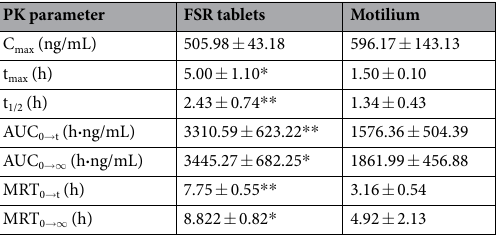
Table 1. Pharmacokinetic parameters of Motilium and DOM-FSR tablets after oral administration of 20 mg (means ± SD, n = 8, * p < 0.05, ** p <